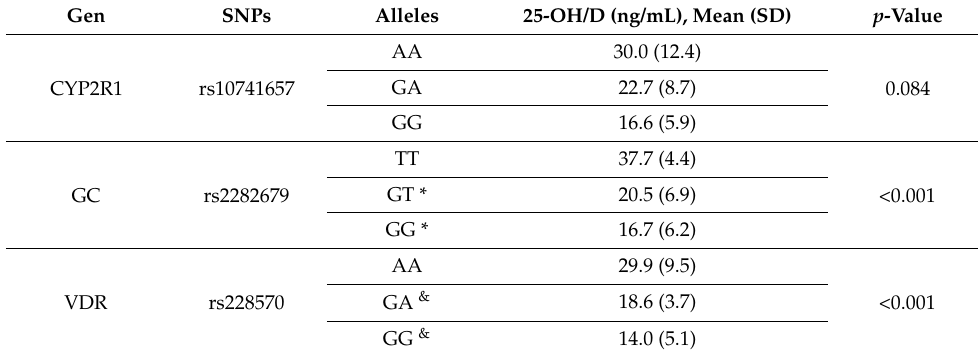
Table 4. Comparisons between single nucleotide polymorphisms vs. 25-hydroxy vitamin